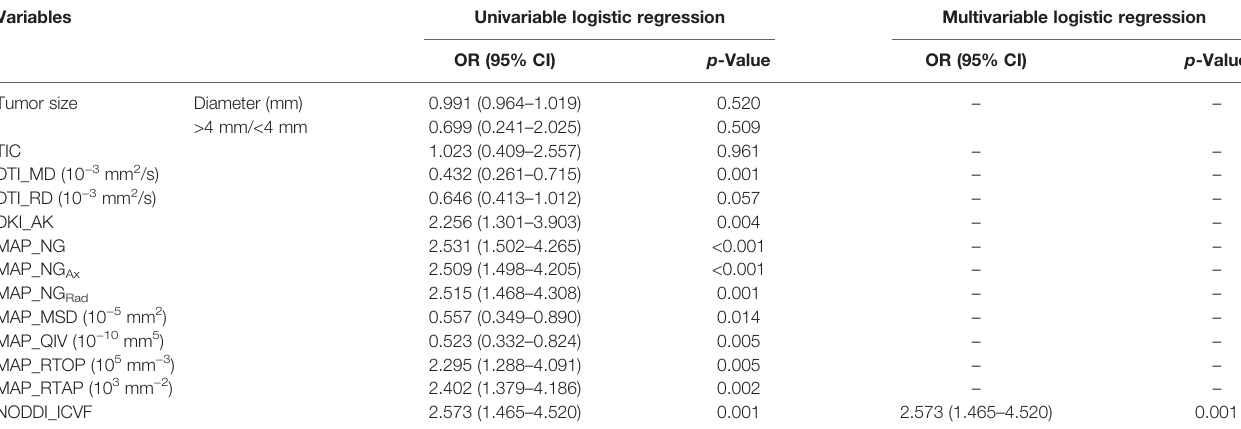
TABLE 5 | Logistic regression analysis of conventional MRI and quantitative DSI parameters in the derivation cohort. Variables Univariable logistic regression Multivariable logistic